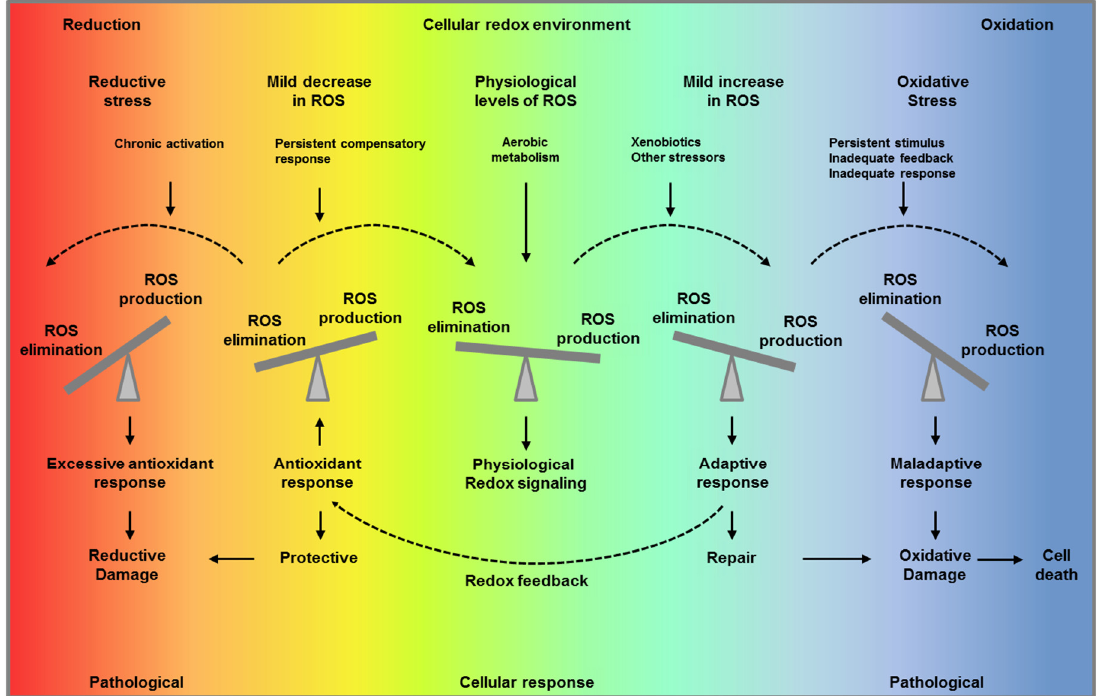
Figure 1. “Optimal redox environment”. Under unstressed conditions, cells maintain redox homeostasis and physiological redox signaling by metabolic fluxes and redox feedback (middle panel, green). A mild increase in reactive oxygen species (ROS) levels triggers an adaptive response to compensate and maintain ROS levels within a physiological range facilitating repair (light blue, first right panel and yellow, first left panel). When the stimulus persist overtime, and the adaptive response is inadequate or / and ROS production is overwhelming, this results in oxidative stress (blue, second right panel). On the other hand, if the compensatory response persists over time decreasing ROS levels below their physiological concentration, this impairs their signaling function and results in reductive stress (red, second left panel). Paradoxically, both reductive stress and oxidative stress are pathological conditions and can lead to ROS production and ultimate to oxidative cell damage and death.